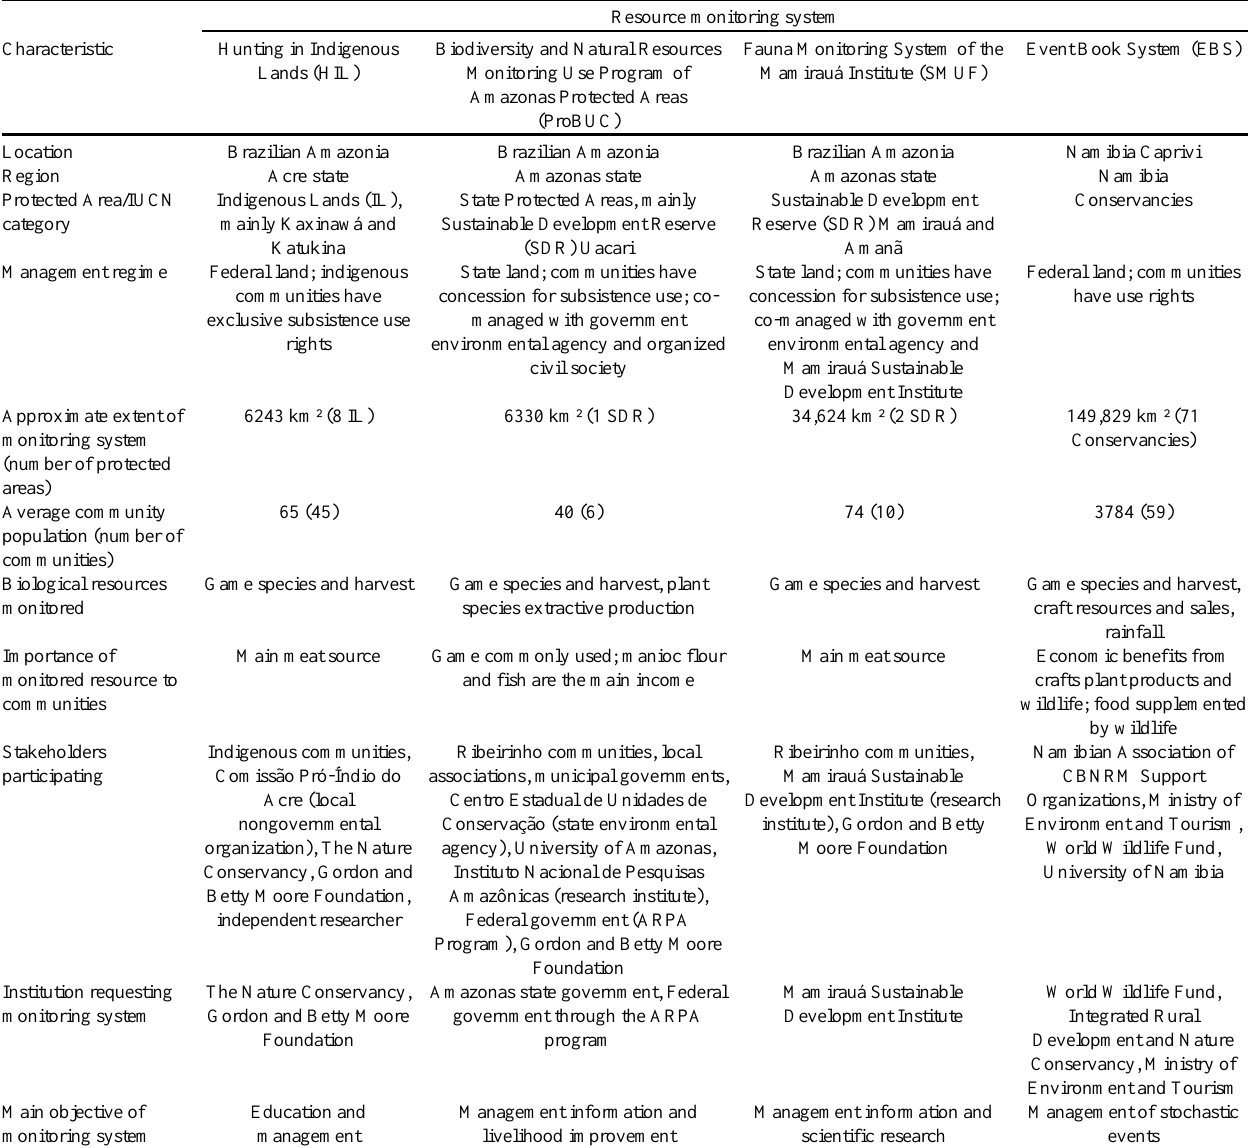
Table 1. Characteristics of biological resource monitoring systems in Brazilian Amazonia and Namibian